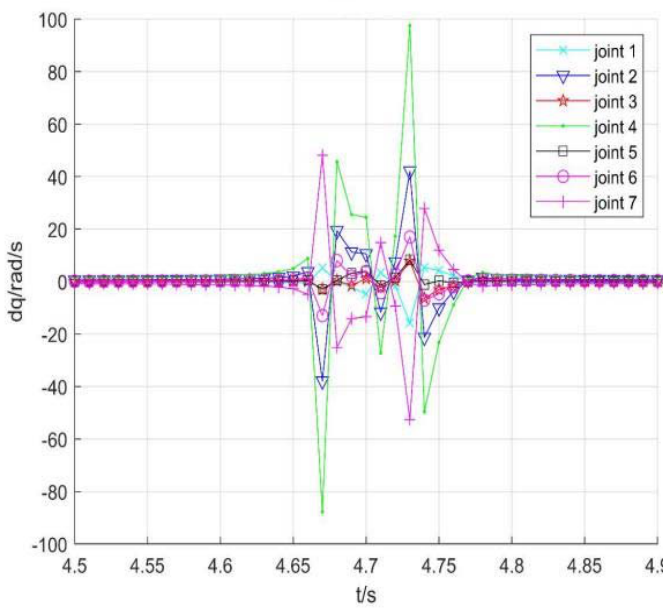
Figure 8. Velocity of each joint.